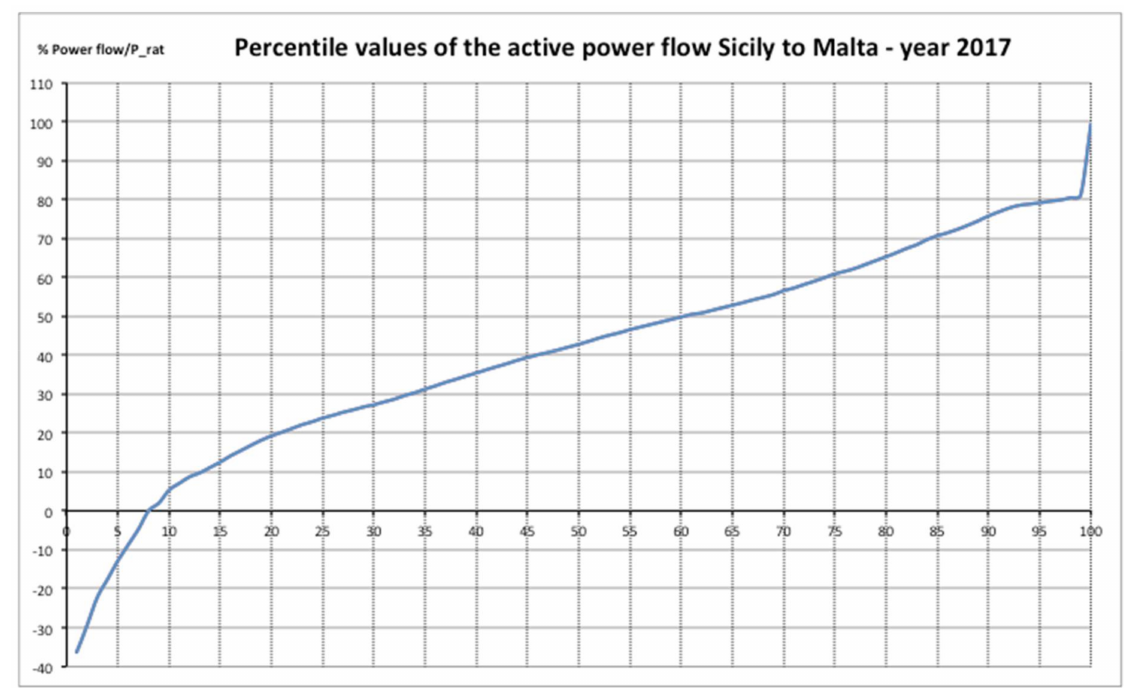
Figure 6. Percentile values Sicily to Malta power flow from January 2017 to January